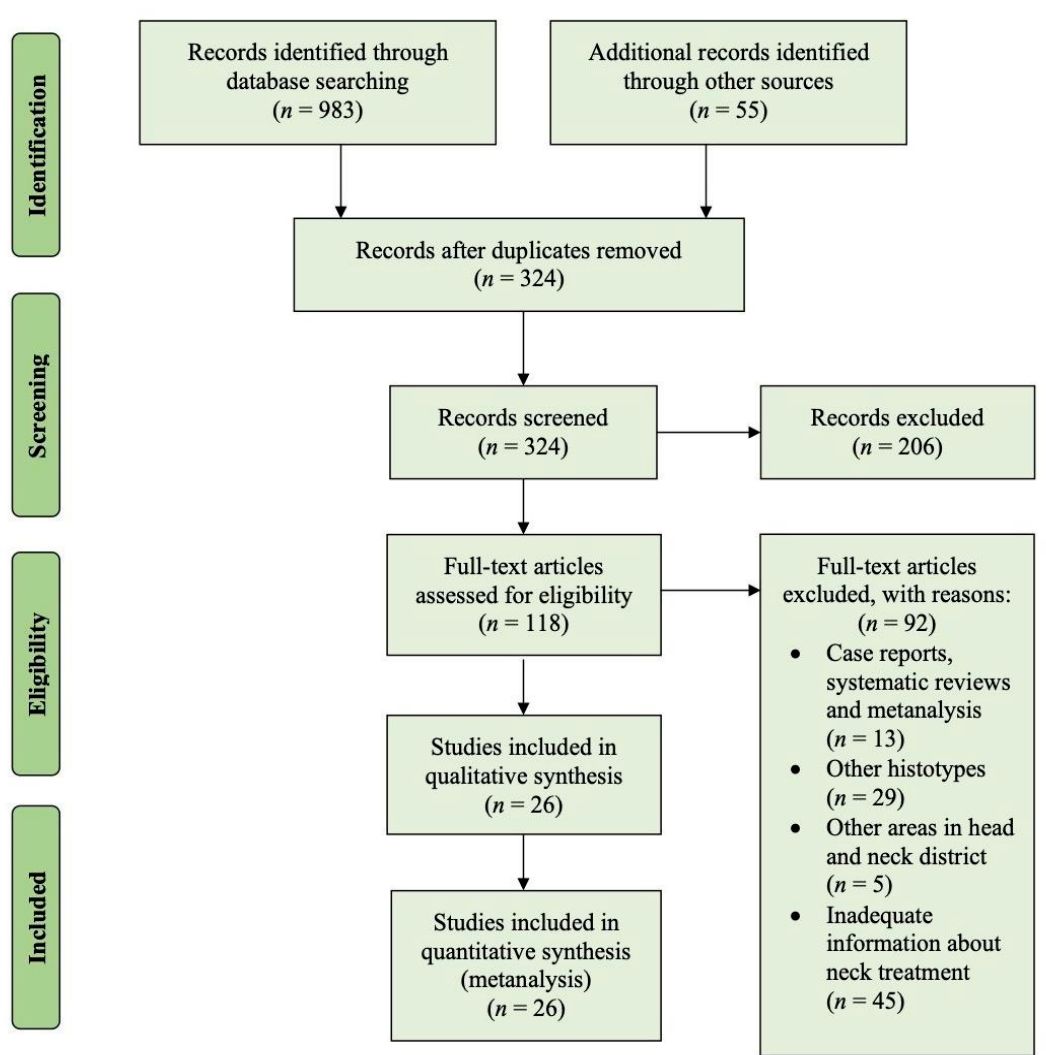
Figure 1. Flow diagram depicting the selection of the papers included in the present review.